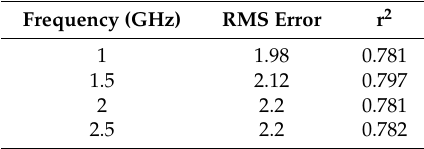
Table 1. Results for prediction of moisture content using β , phase delay (density unknown).